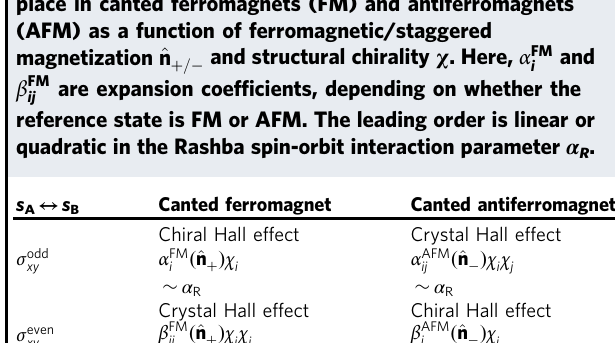
Table 1 Uni fi ed categorization of various Hall effects taking place in canted ferromagnets (FM) and antiferromagnets (AFM) as a function of ferromagnetic/staggered magnetization ^ n þ = (cid:2) and structural chirality χ . Here, α FM i